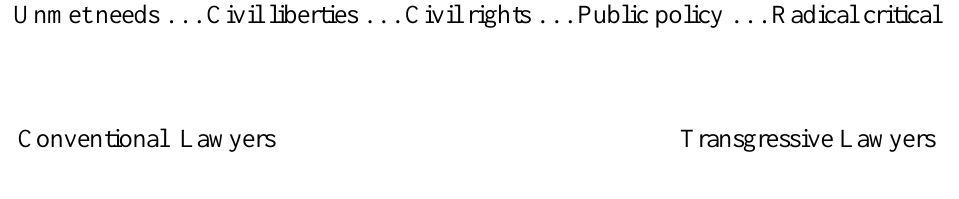
Figure 1 . Lawyering